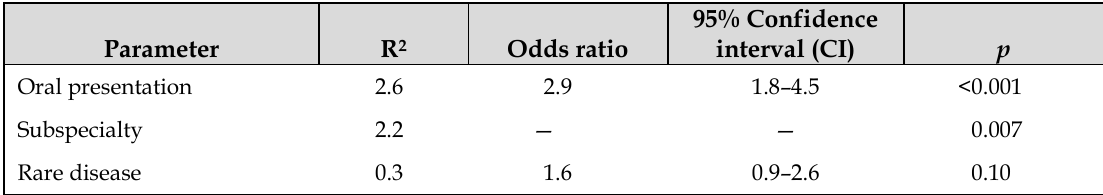
Table 3 Multivariate binary logistic regression analysis of factors predicting publication